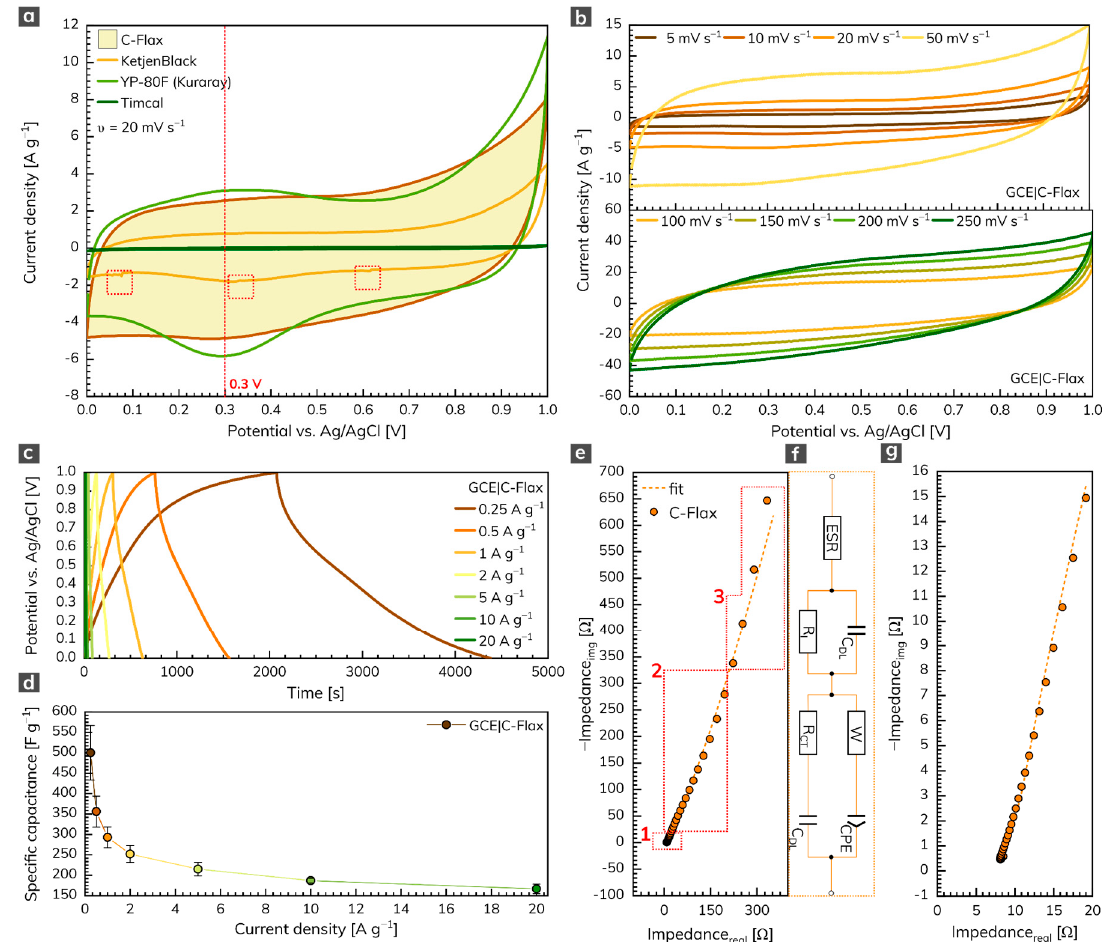
Figure 3. ( a ) CVs of C-Flax and different commercially available samples recorded at a constant scan rate of 20 mV s –1 . ( b ) CVs of C-Flax sample recorded at scan rates ranging from 5 to 250 mV s –1 . ( c ) GCD curves of C-Flax sample recorded at different current densities and ( d ) corresponding specific capacitance vs. current density profile. ( e ) Nyquist plot of the C-Flax sample, its magnified version ( g ), and electrical circuit used for data fitting ( f ). All experiments were performed in 1 mol L –1 sulfuric acid.